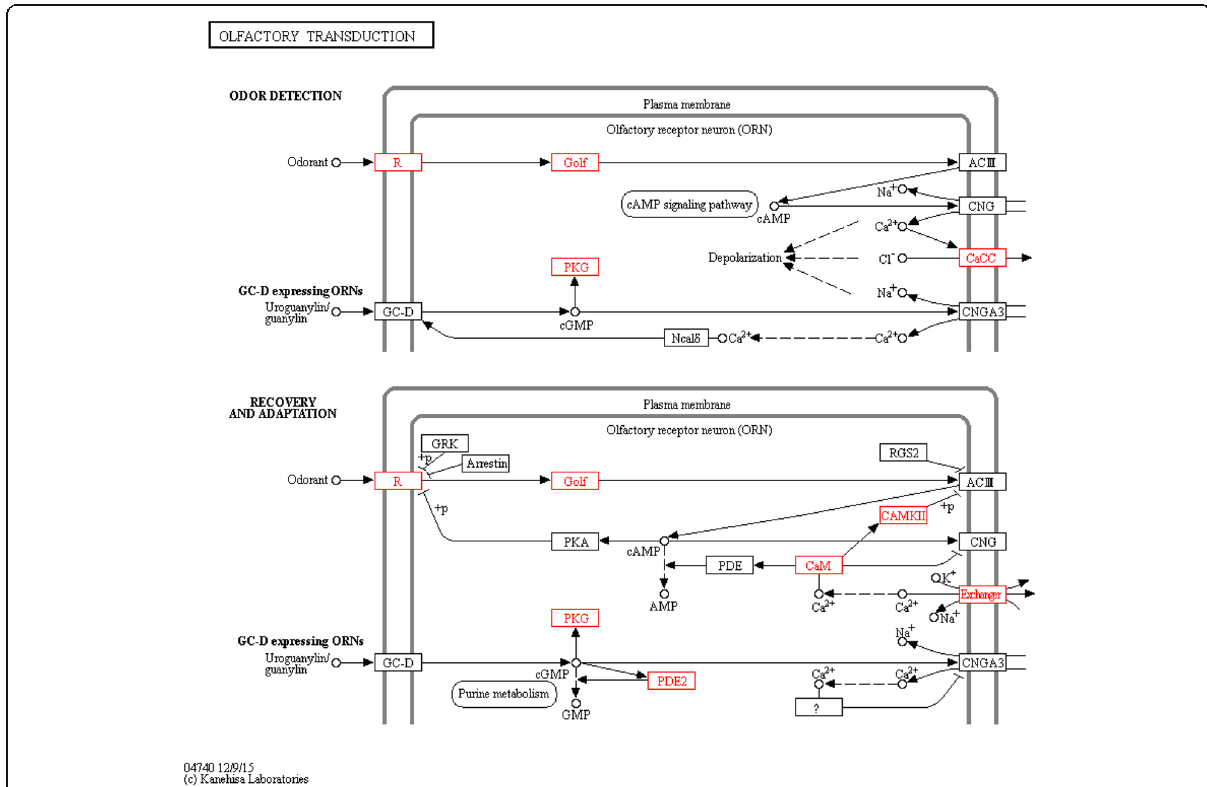
Fig. 3 Pathway mapping of BMI-associated genes within the olfactory transduction network (red boxes). The following genes were computed: SLC8A1 , OR4D2 , ANO2 , PDE2A , CALML3 , GNG7 , PRKG1 , OR51A7 , CAMK2D , CALML6 , OR2T34 , and OR2Y1 . Figure taken from KEGG reference database (map04740). Pathway enrichment analyses, based on pathDIP ( p = 1.94 × 10 − 10